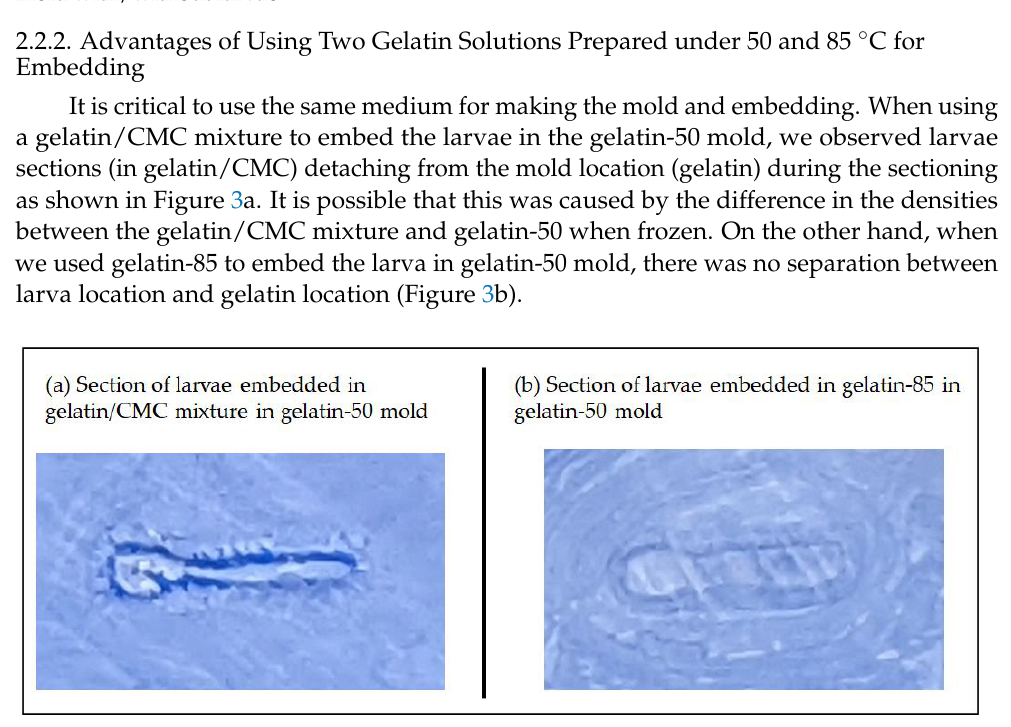
Figure 3. ( a ) Section of larvae embedded in gelatin/CMC then in gelatin-50 mold showing the de- tachment of gelatin/CMC from gelatin; ( b ) section of larvae embedded in gelatin-85 then in gelatin- 50 mold showing perfect embedding of larvae in the gelatin .